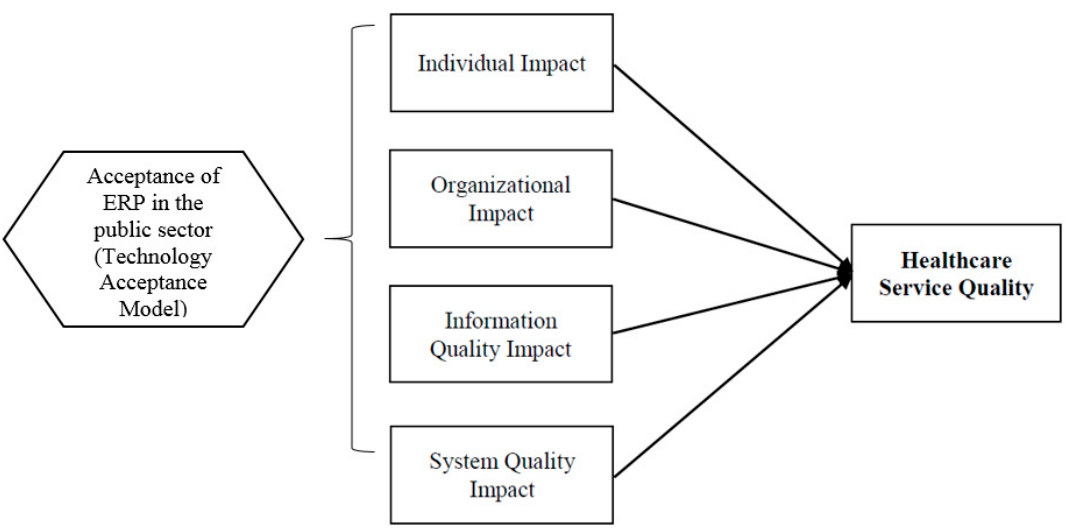
Figure 1. The proposed research model.